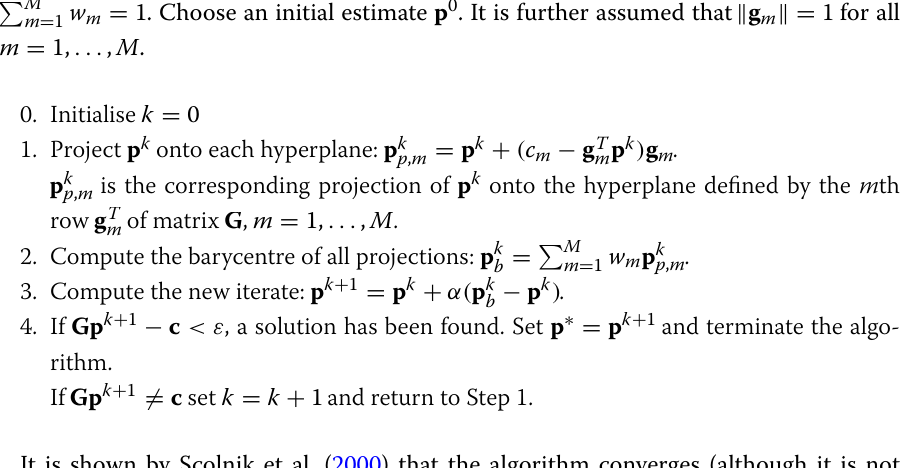
α > 0 , ε > 0 , and w m , m = 1, . . . , M with